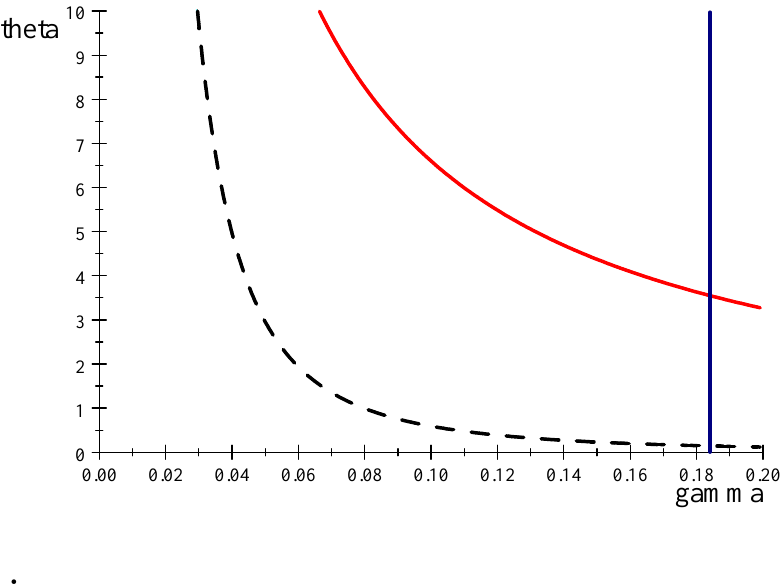
Figure 12: Changes of labour market tightness with respect to vacancy posting cost: